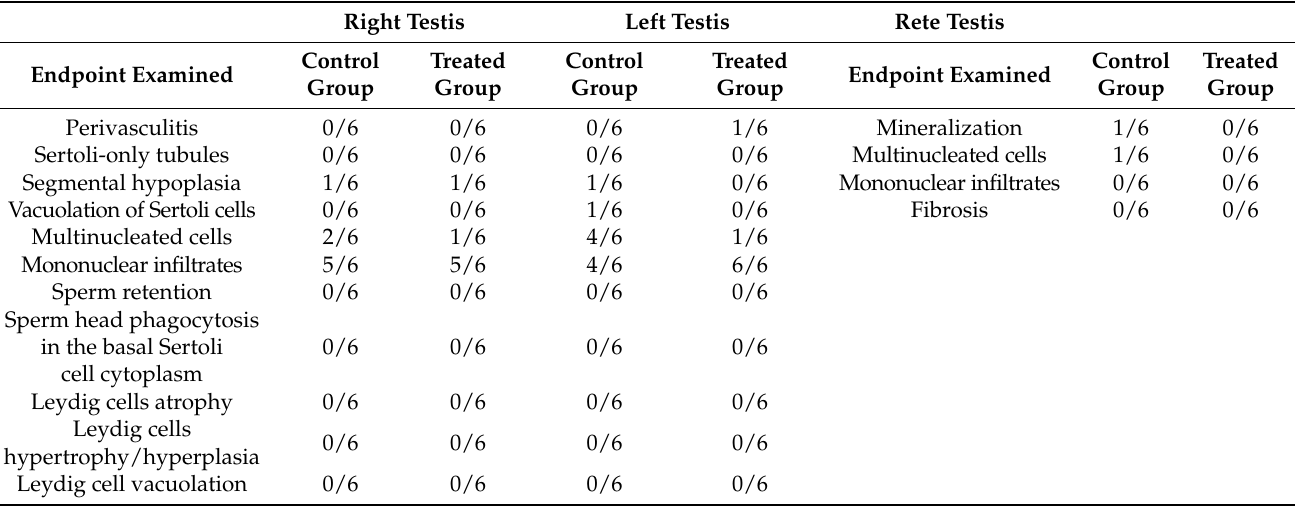
Table 2. Incidence of histopathological findings in right and left testes and rete testis of control and BPA-treated rams. Only mild lesions were detected in every endpoint